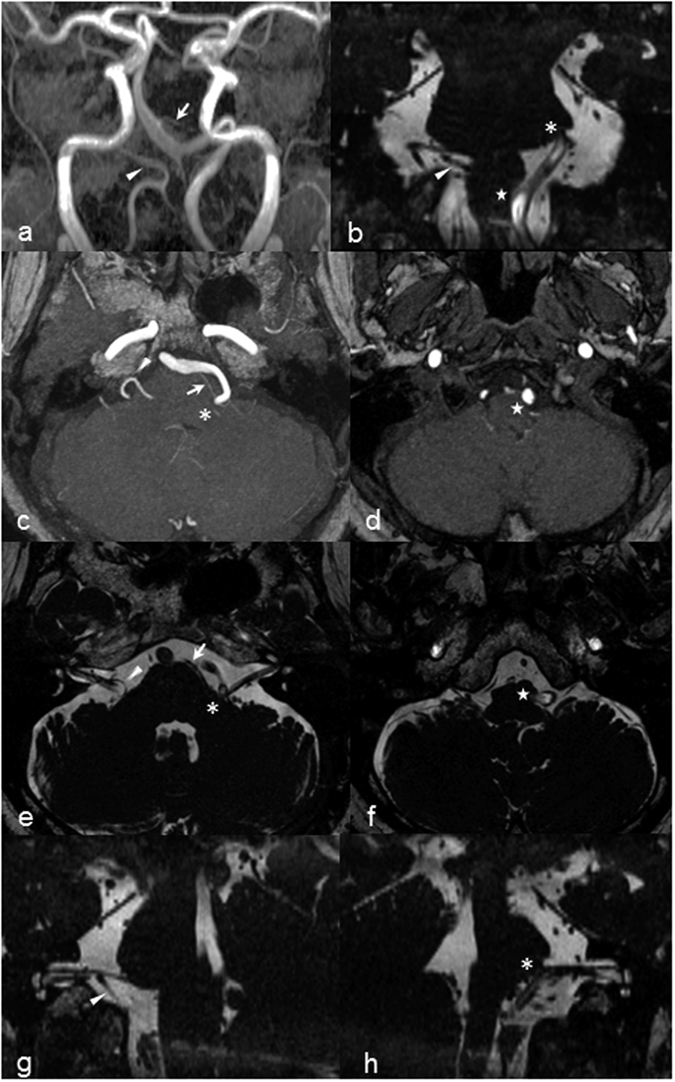
Brain MRI of a hypertensive male with left hemifacial spasm.(a) Coronal MRA MIP image showing dolichoectatic of the vertebrobasilar arteries. (b) Coronal CISS image showing compression and indentation on the left facial nerve REZ and left VLM by the tortuous left VA. Axial MRA MIP images showing vascular compression at the level of the (c) pons by the left VA and AICA, and (d) medulla by the left VA. Corresponding axial CISS images detailing compression at the left (e) facial nerve REZ and (f) VLM. Oblique sagittal reconstructed CISS images along the facial nerve on the (g) right showing normal lie of the nerve with PICA nearby and pregnant pontine belly, and (h) left showing pontine distortion and elevated facial nerve REZ. (Abbreviations: AICA = anterior inferior cerebellar artery; CISS = constructive interference at steady state; MIP = maximum intensity projection; MRA = magnetic resonance angiography; PICA = posterior inferior cerebellar artery; REZ = root exit zone; vertebral artery = VA; VLM = ventrolateral medulla. Annotations: arrow = left AICA ; arrowhead = right PICA, asterisk = REZ of left facial nerve; star = left VLM compression).